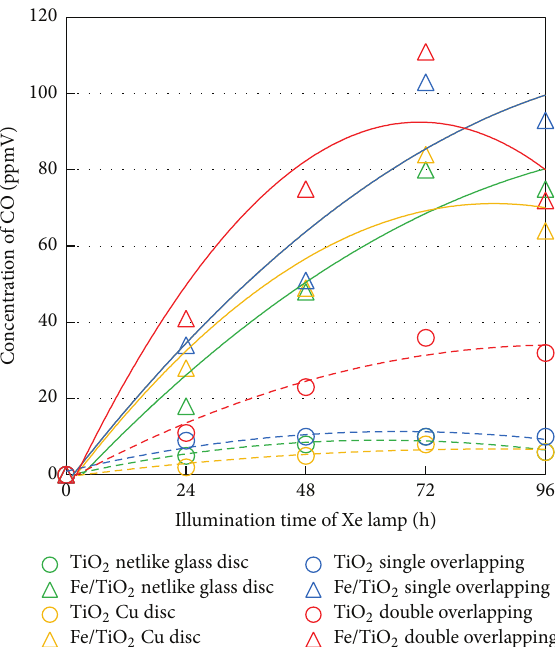
Figure 15: Comparison of concentrations of produced CO among photocatalysts coated on different base materials under the illumi- nation condition without UV